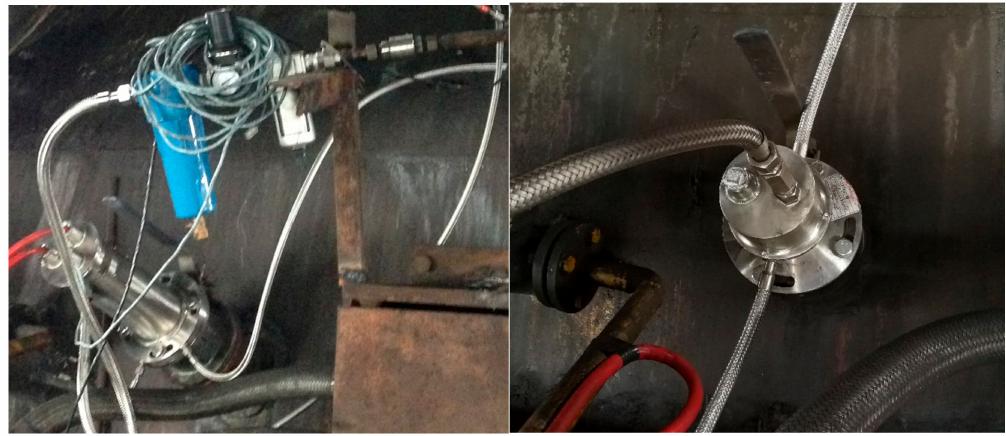
Figure 6. Installed industrial